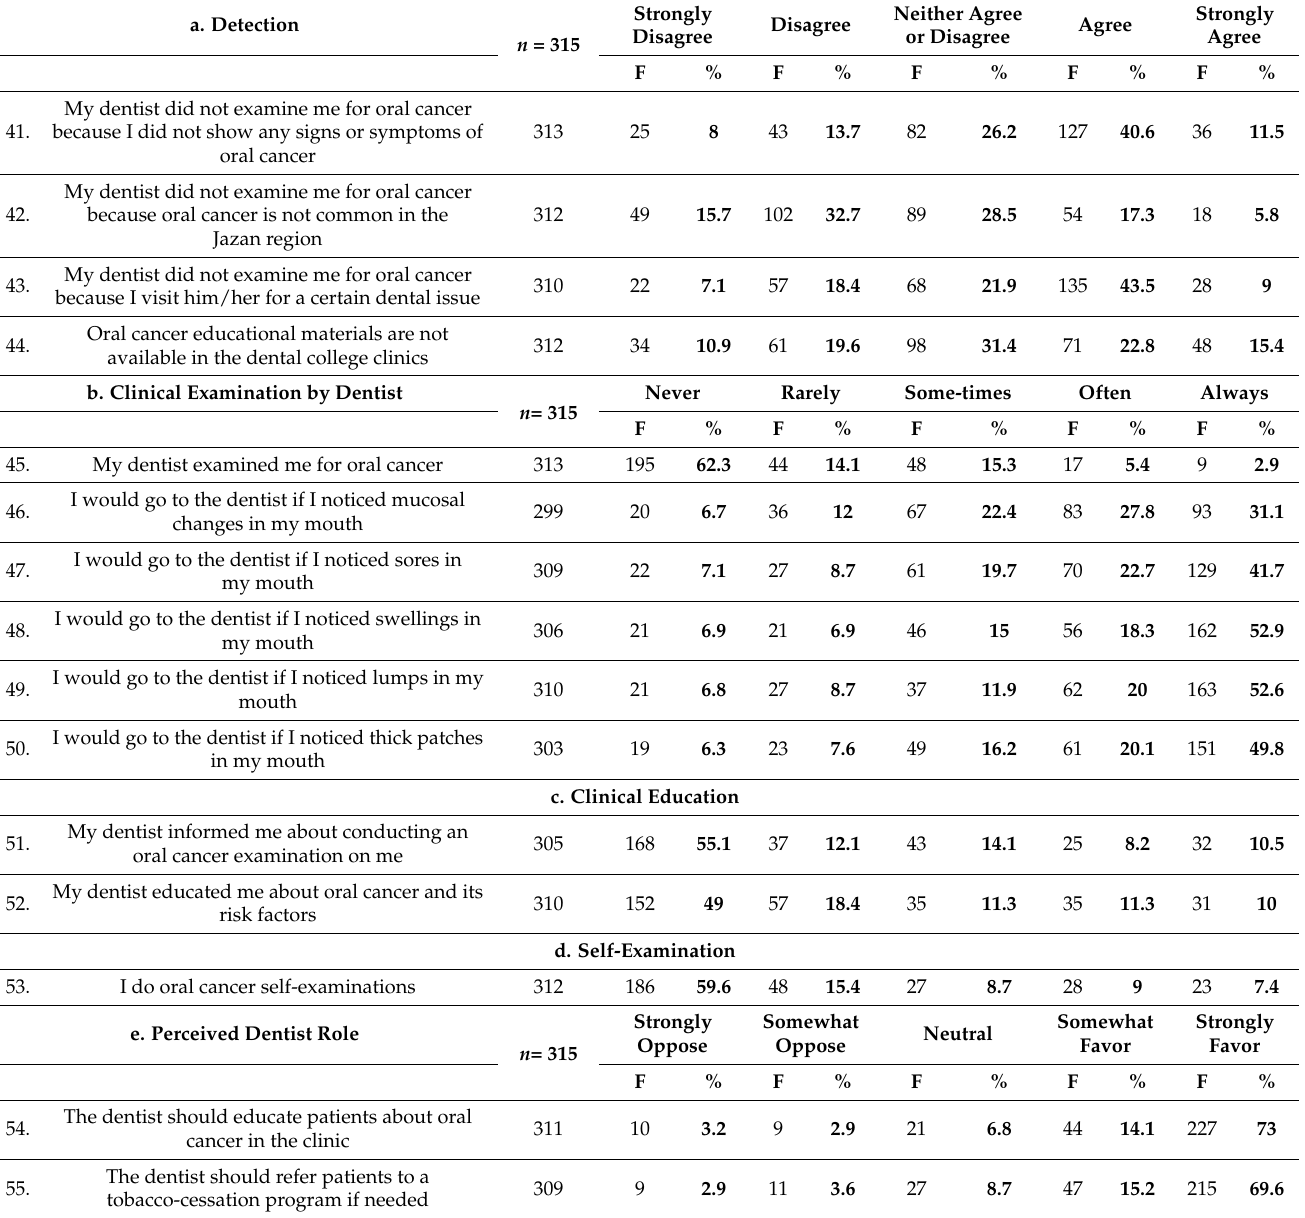
Table 4. Dental patients’ practice toward oral